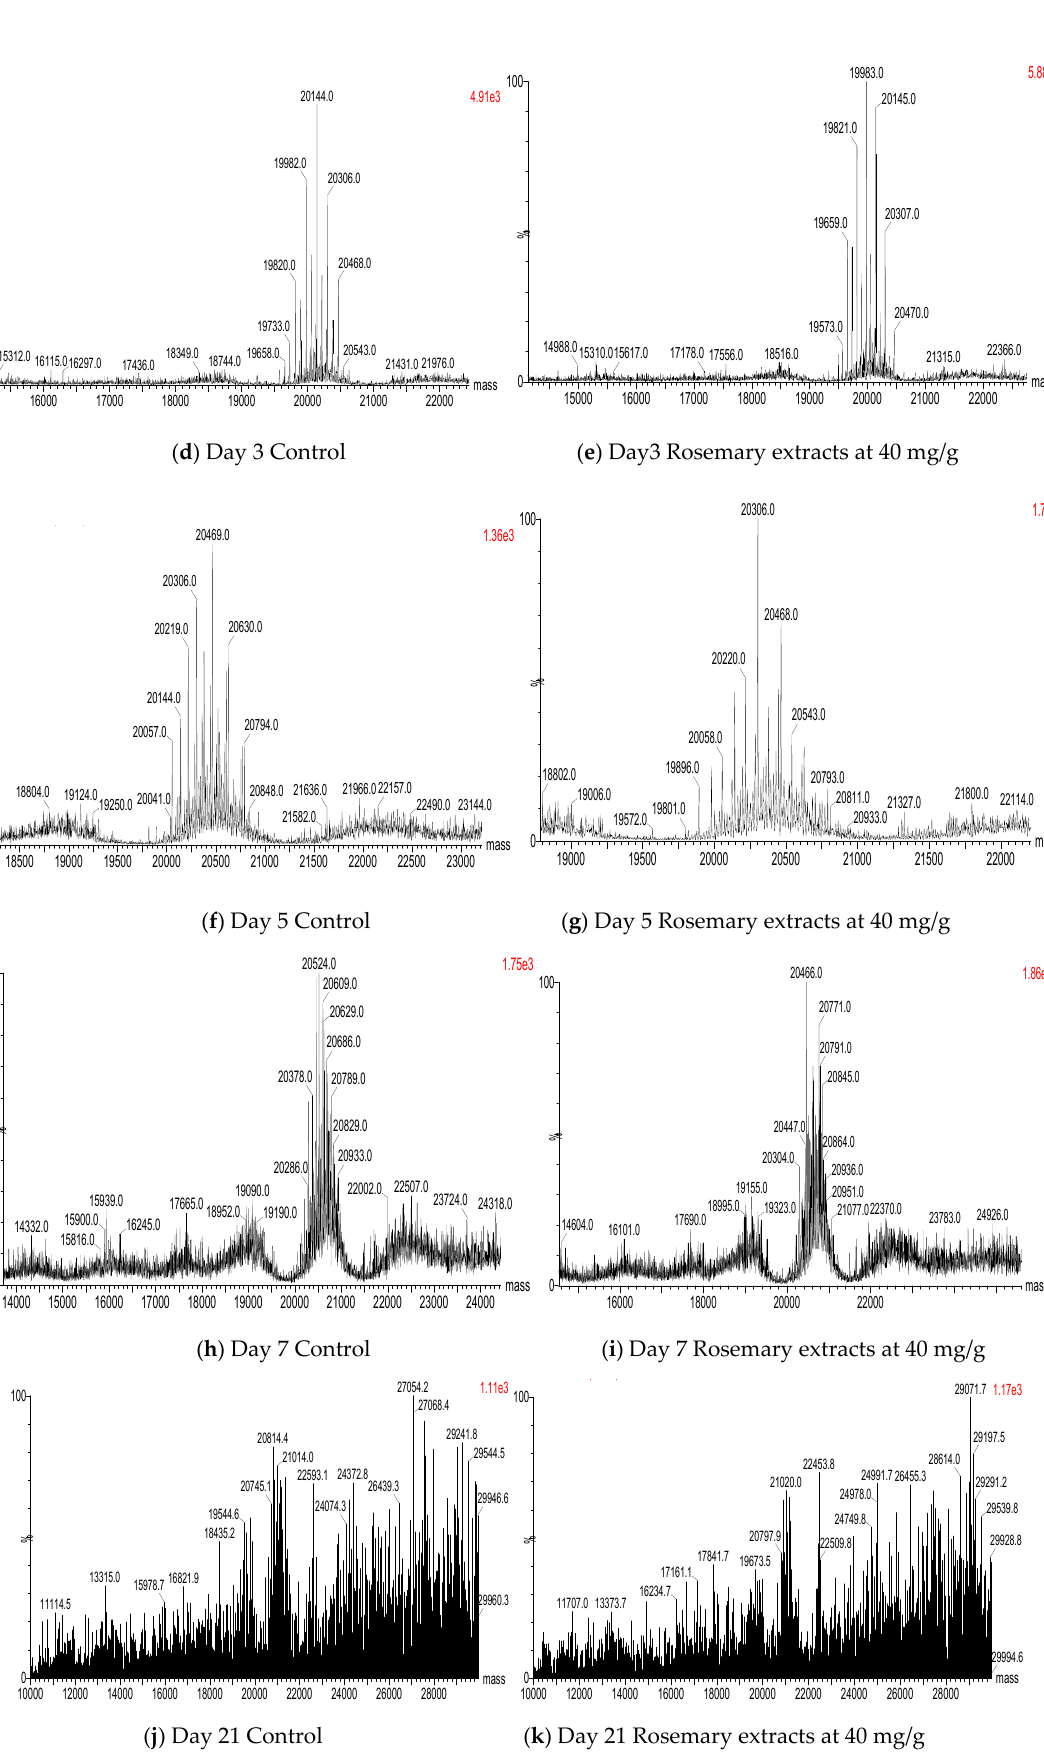
Figure 4. Mass spectrums of protein glycation in control and RE treatment during storage.